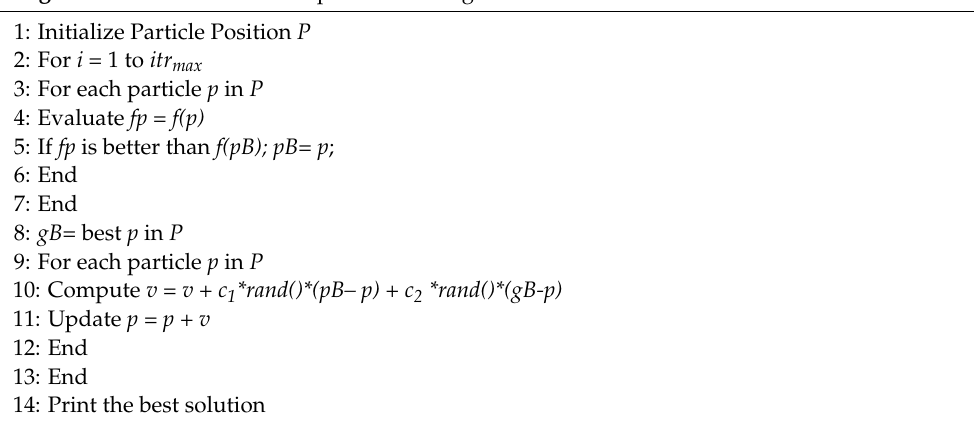
Algorithm 4 Particle Swarm Optimization Algorithm